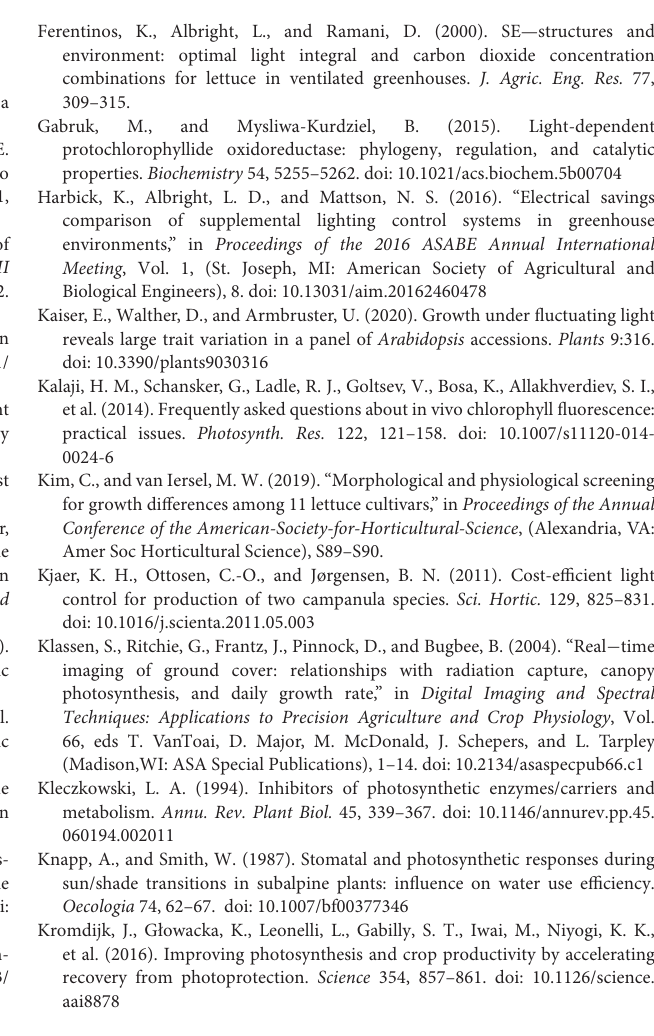
Supplementary Figure 2 | Stomatal conductance of ‘Green Salad Bowl’ lettuce ( Lactuca sativa ) during a 15 min high PPFD period followed by a 15 min